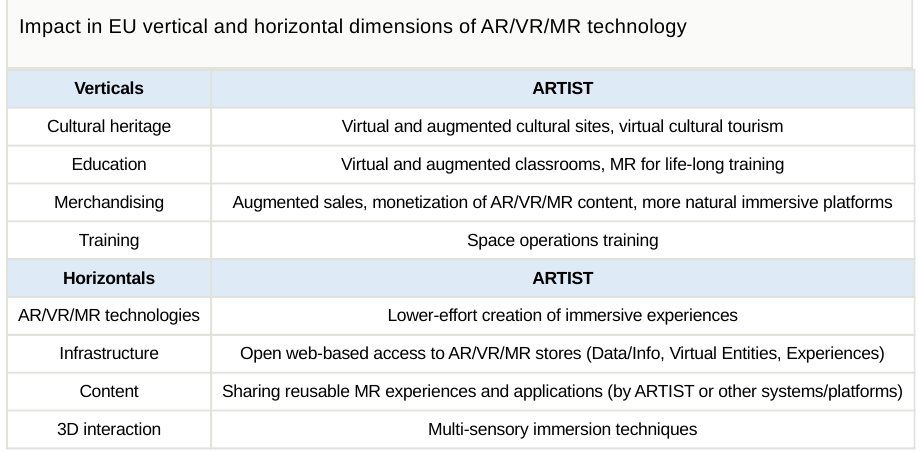
ARTIST - a reAl-time low-e ff oRt mulTi-entity Interaction System for creaTing